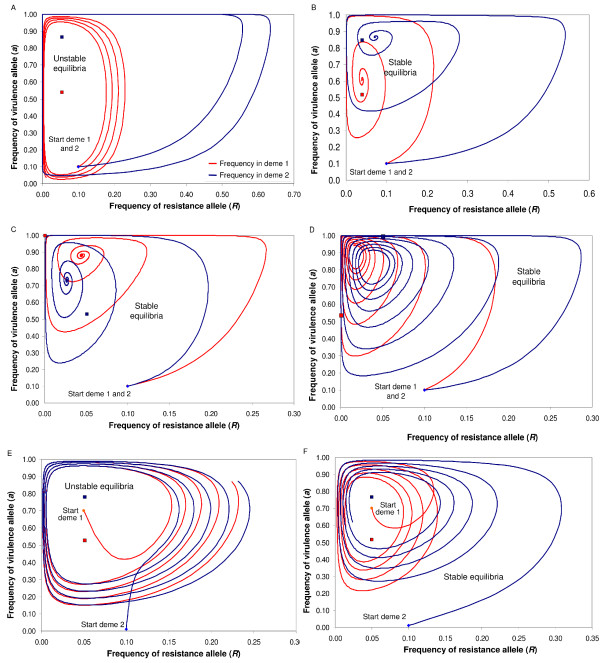
Dynamics of allele frequencies in a two-deme model with unequal parameter values between demes. The positions of the calculated equilibria are shown for single populations with no migration (red and blue rectangle for deme 1 and 2; for simplicity, c = 1). a) Different costs of disease, no migration (u1 = u2 = 0.05, b1 = b2 = 0.05, s1 = 0.1, s2 = 0.3, m = 0): unstable dynamics, as the graph of (R,a) spirals outwards with different frequencies in each deme. b) Different costs of disease, with migration (u1 = u2 = 0.05, b1 = b2 = 0.05, s1 = 0.1, s2 = 0.3, m = 0.03): stable dynamics, with synchronised oscillations in the two demes spiralling inwards towards the interior equilibrium points. c) Fitness costs of RES and avr in one deme but not the other (b2 = u2 = 0.05, b1 = u1 = 0, s1 = s2 = 0.1, m = 0.03): synchronised, stabilising oscillations. d) No cost of RES in one deme, no cost of avr in the other (b1 = u2 = 0, b2 = u1 = 0.05, s1 = s2 = 0.1, m = 0.03): synchronised, stabilising oscillations. e) Identical costs of resistance and virulence but different costs of disease (b1 = b2 = 0.05, u1 = u2 = 0.05, s1 = 0.1, s2 = 0.2), initial allele frequencies are (R, a) = (0.05, 0.7) in deme 1 and (0.1, 0.01) in deme 2: unstable dynamics occurs if migration m = 0.2. f) Identical parameters as in (e), initial allele frequencies are (0.05, 0.7) in deme 1 and (0.1, 0.01) in deme 2: stable dynamics occurs if migration m = 0.03.